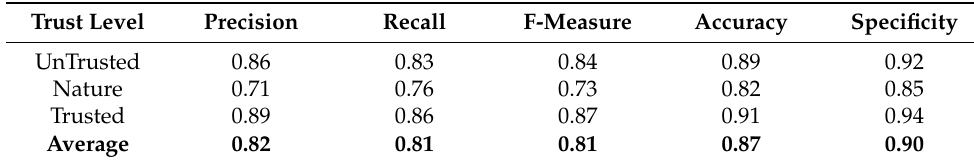
Table 6. Experimental Results in Other